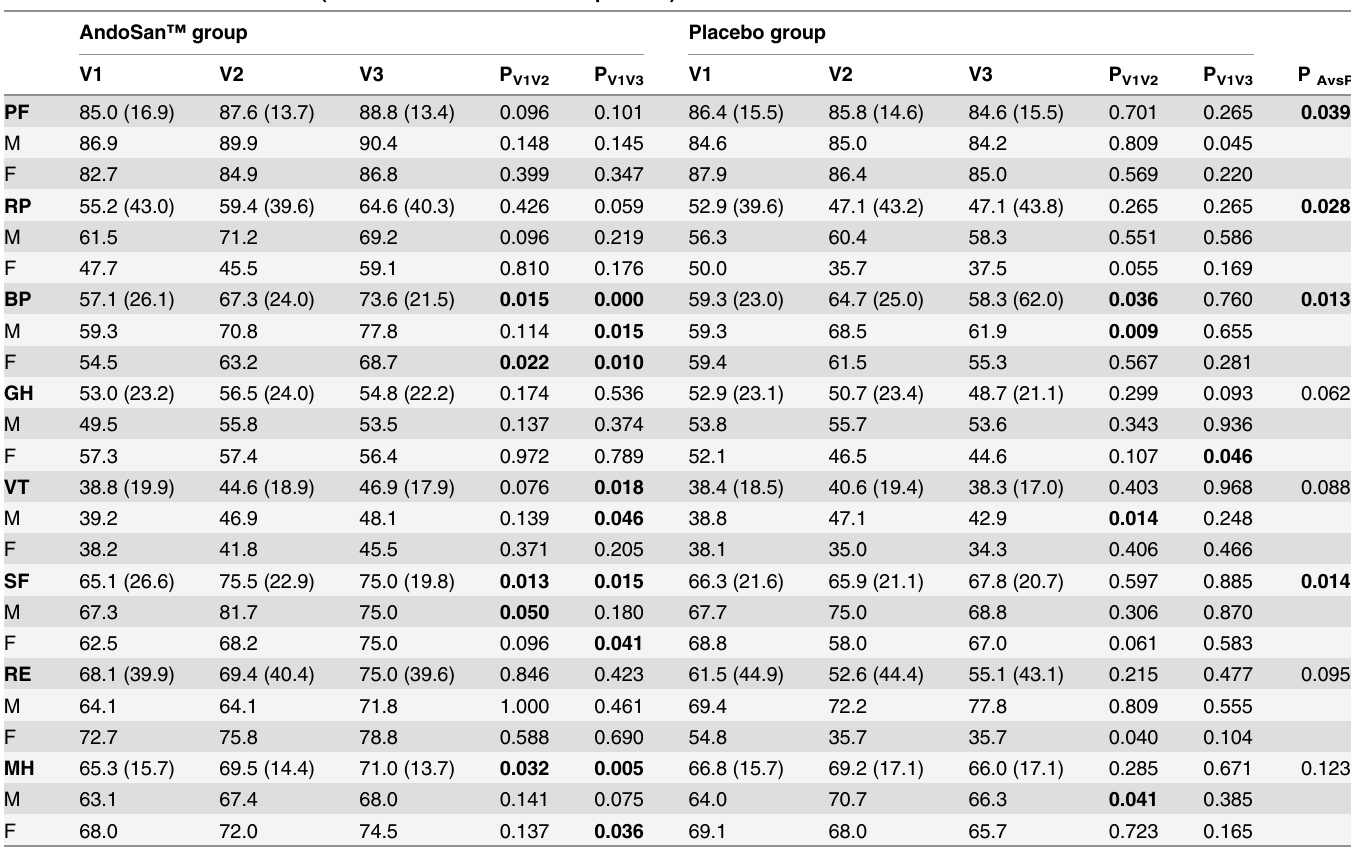
Table 6. Mean SF-36 scale scores (n = 24 AndoSan ™ and n = 26 placebo) UC. AndoSan ™ group